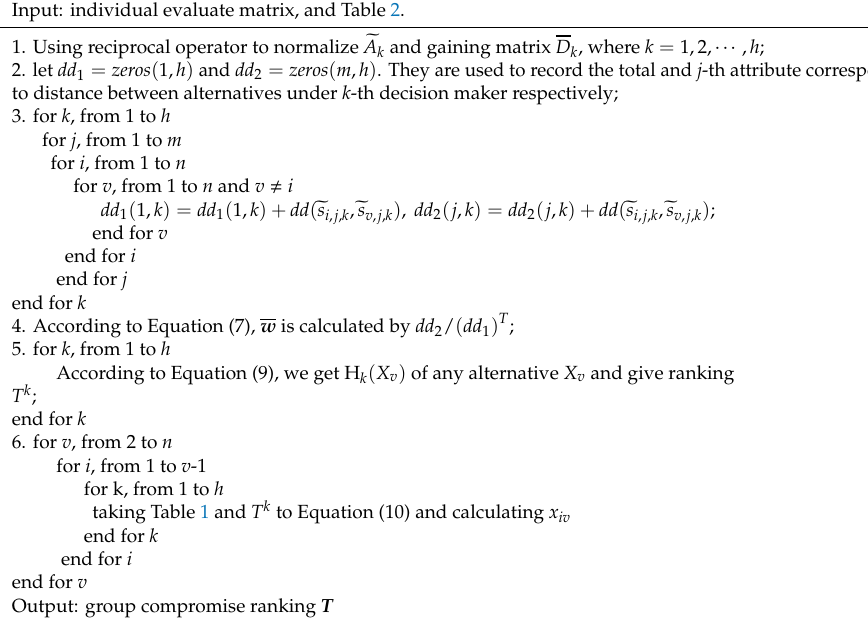
Table 3. The pseudocode of uncertain multiplicative linguistic decision